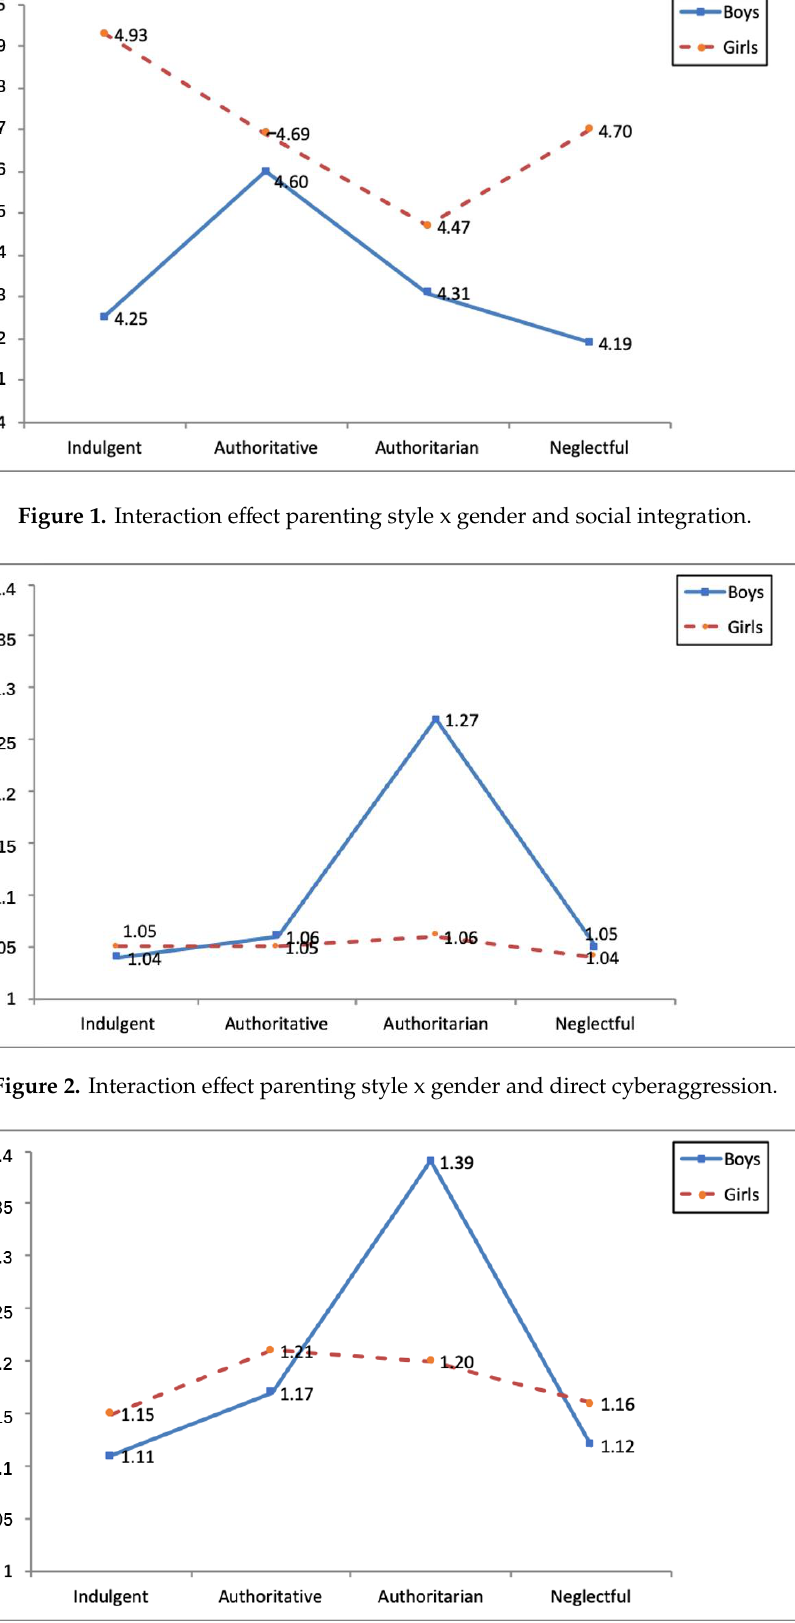
ff ect parenting style x gender and indirect Figure 3. Interaction effect parenting style x gender and indirect cyberaggression. Figure 3. Interaction e